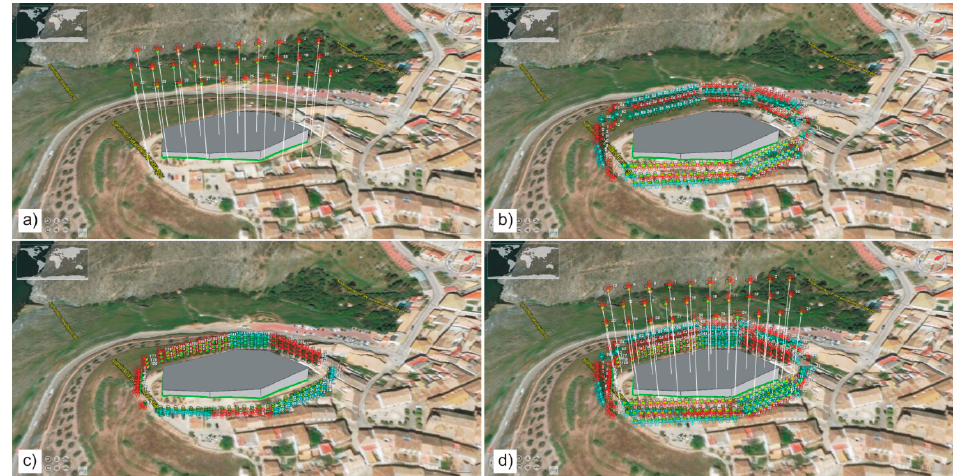
Figure 11. Planning of the castle case: ( a ) block flight, ( b ) corridor flights considering 5° and 30° inclination angles, ( c ) polygon extrusion flight, and ( d ) combination of the three flights.